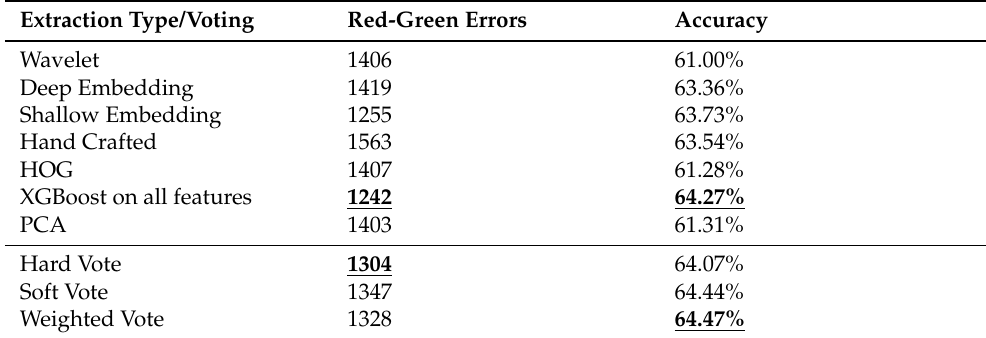
Table 7. Critical classification errors achieved by best instance of classifier for each feature set and voting